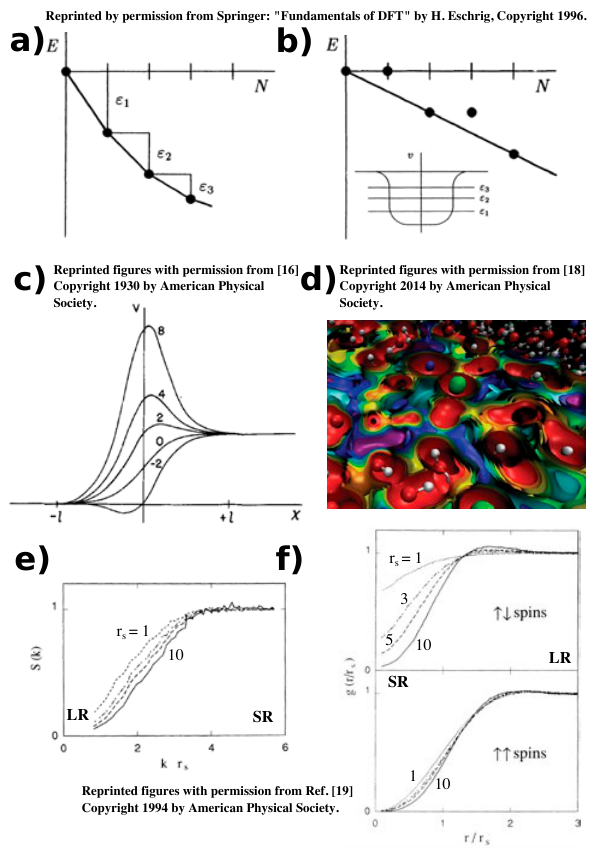
Figure 1. Long-range (left) and short-range (right) theories of elec- tronic structure. (a) and (b) show free energy vs. electron num- ber for a potential well. 15 (c) shows ‘Epstein’ profile of dielectric response 16,17 at a metal/vacuum interface. Numbers for each curve give the surface/bulk conductivity ratio. (d) shows surfaces of con- stant voltage at a water/vacuum interface, (e) and (f) show the cor- relation function of jellium from accurate calculations.